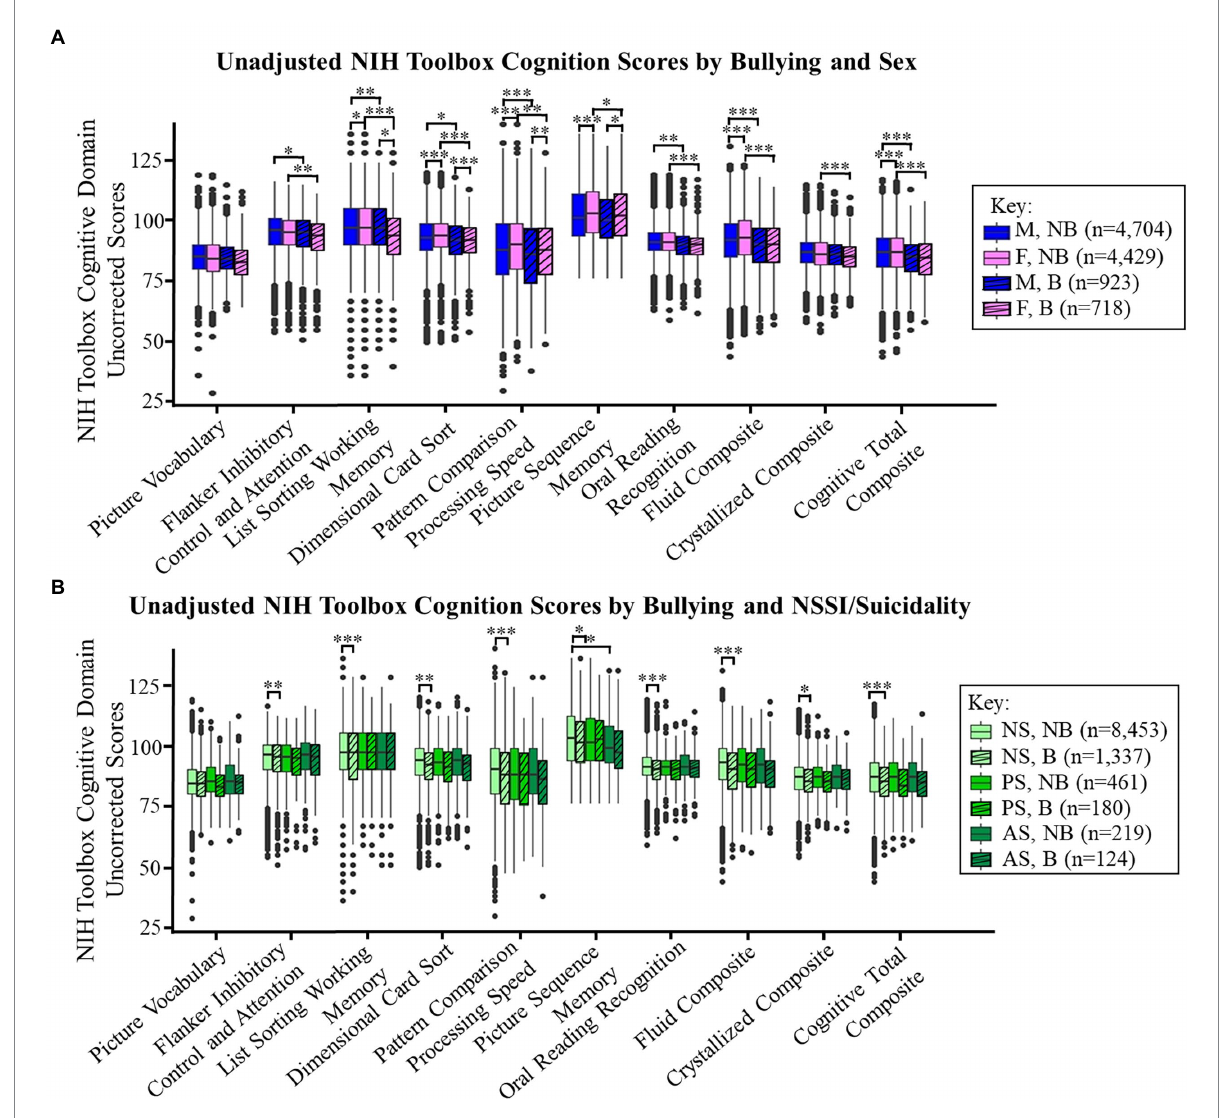
FIGURE 4 (A,B) display the NIH Toolbox Cognitive Domain uncorrected score means by bullying (striped) based on (A) sex or (B) by NSSI/suicidality (NS: non-suicidal, PS: NSSI or passive suicidal ideation, AS: active suicidal ideation or suicide attempts). Significant p -values are marked with asterisks (* <0.05, ** <0.01, *** <0.001). B, bullied and NB,